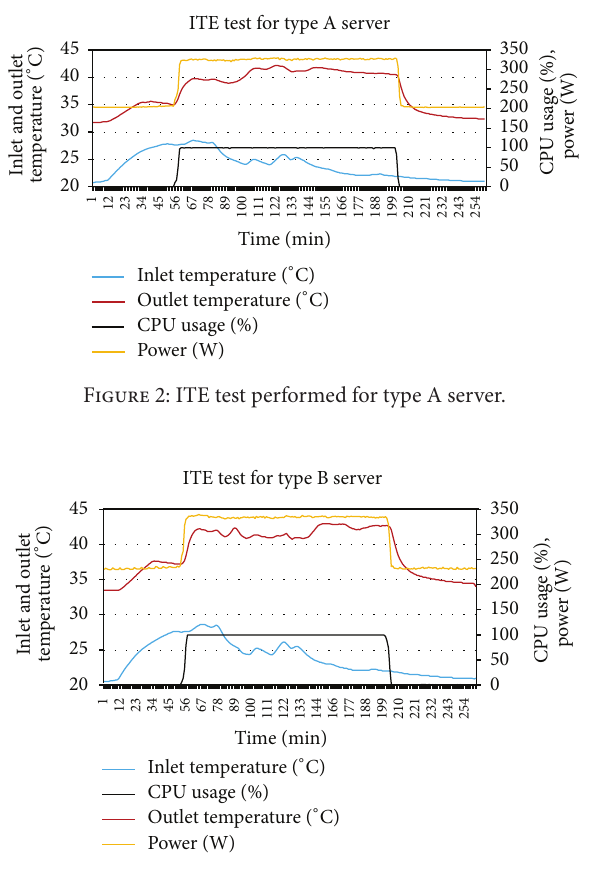
Figure 3: ITE test performed for type B server.